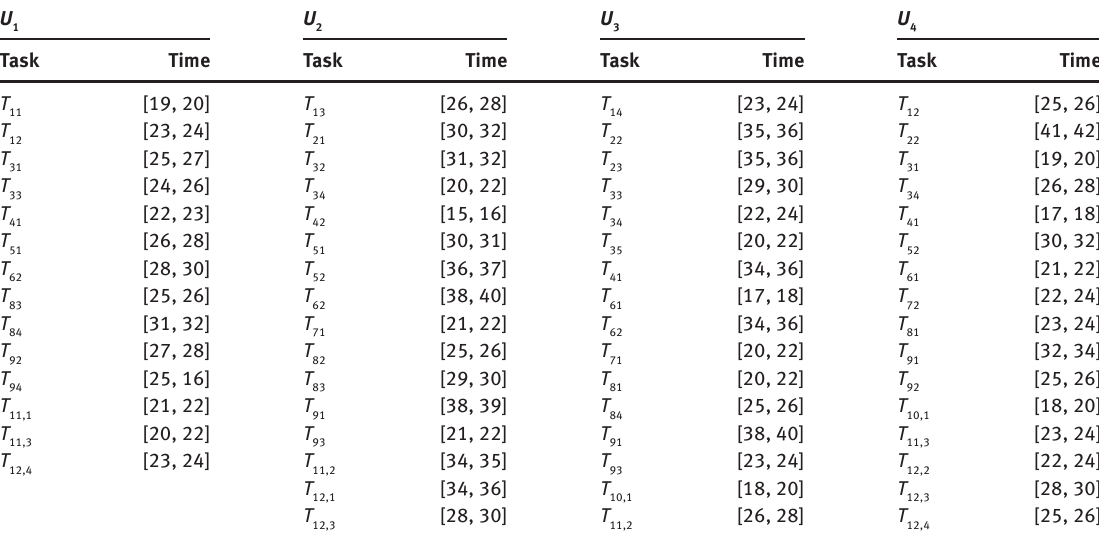
Table 2: Design Capability Attributes of VDUs. U 1